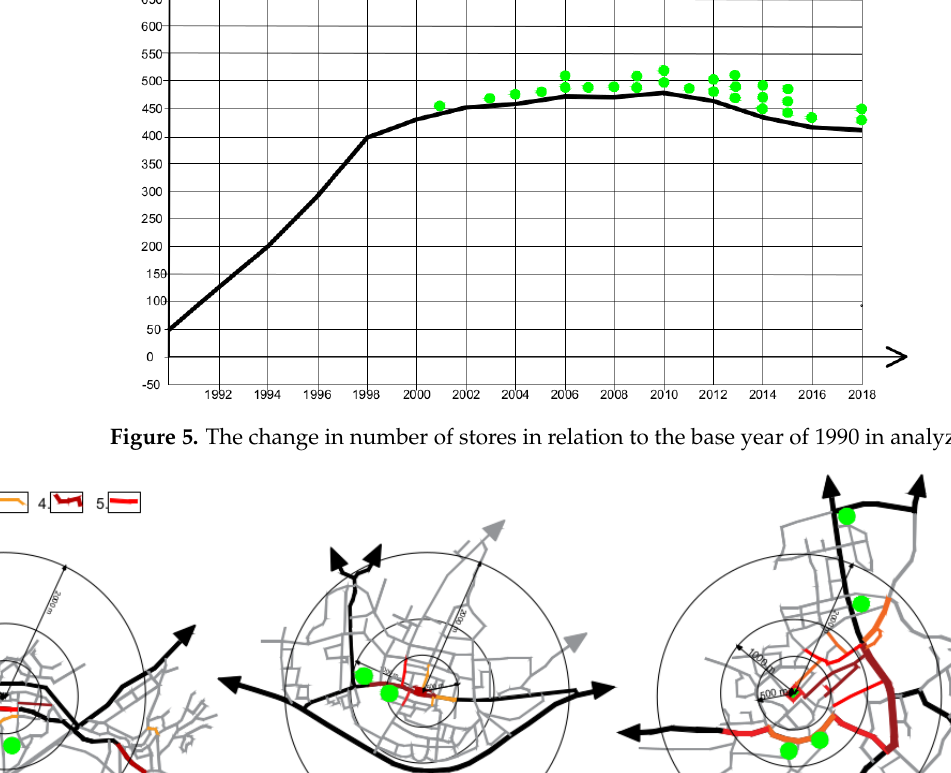
Figure 5. The change in number of stores in relation to the base year of 1990 in analyzed towns.